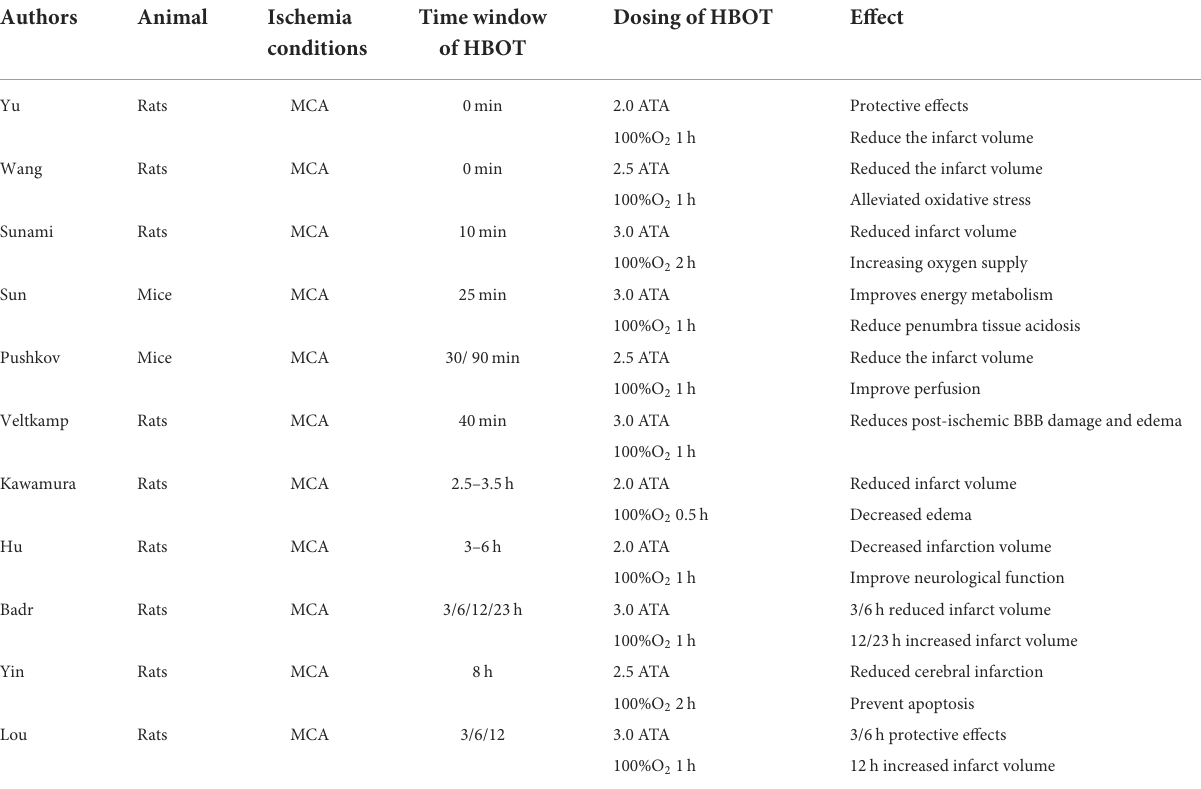
TABLE 1 Experimental results of animal models of temporary middle cerebral artery occlusion treated with